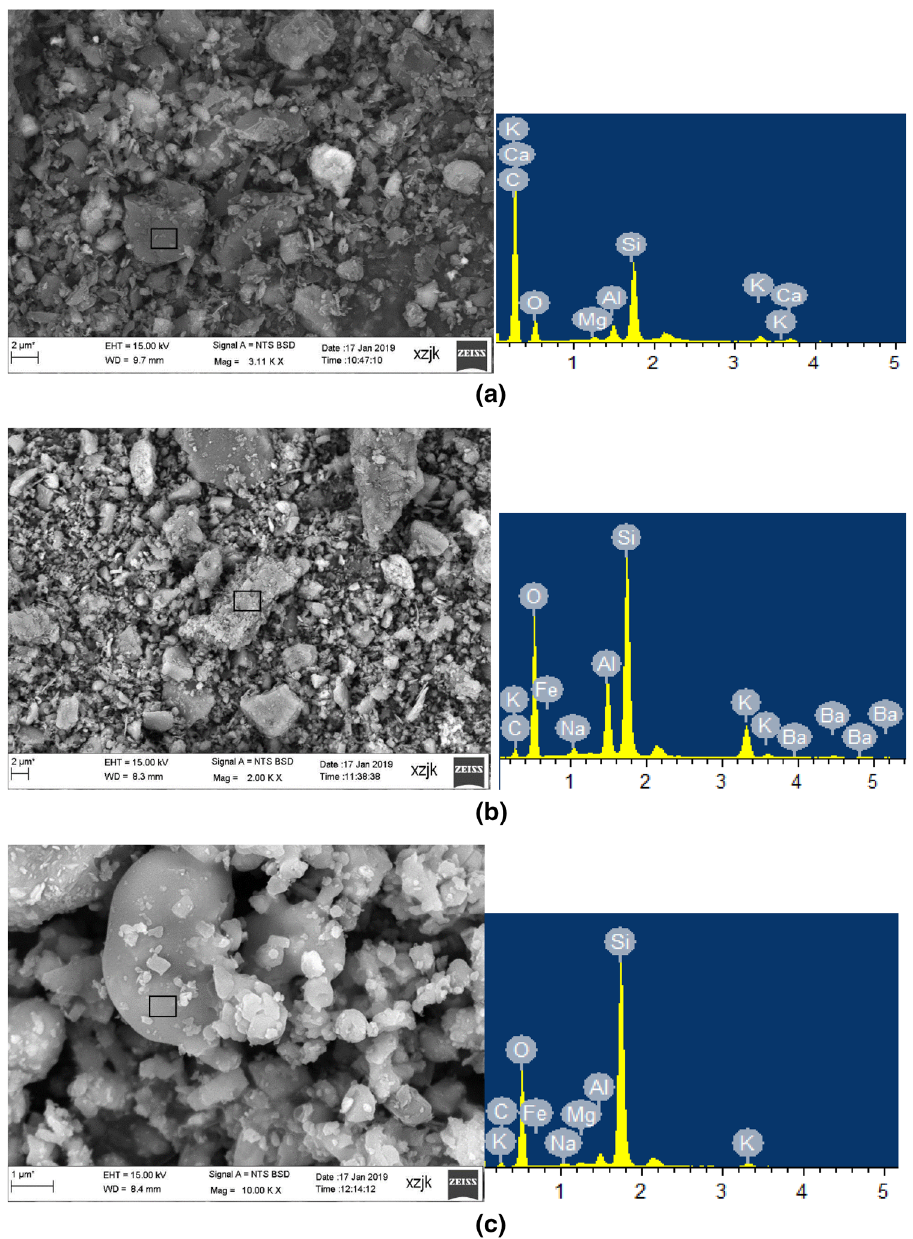
Fig. 3 SEM images and mineral components of a raw stone coal, b coal ash heated at 600 (cid:3) C, and c coal ash heated at 1000 (cid:3)